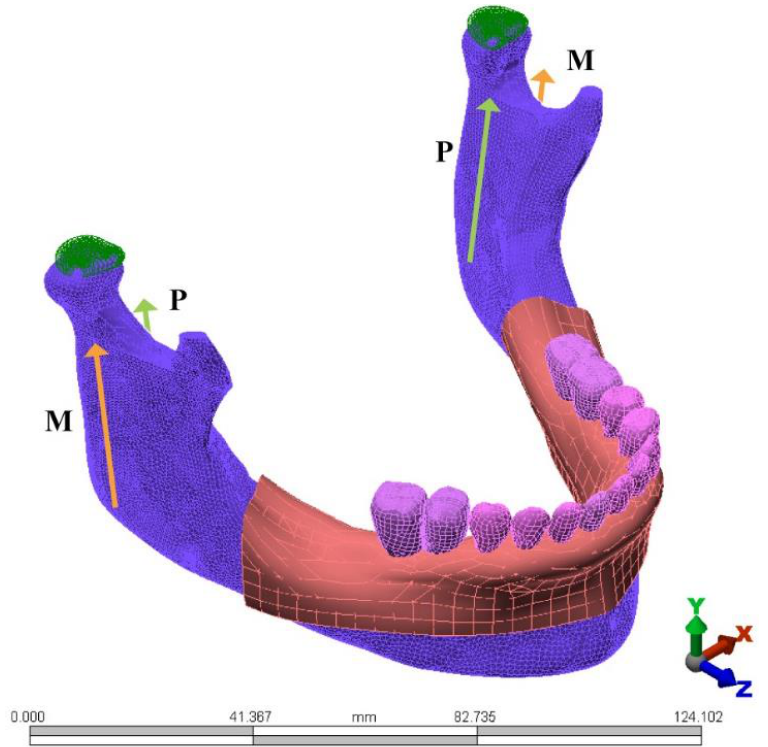
Figure 3. Complete mandible assembly in the simulation environment with applied forces corresponding to pterygoid muscles (P) and the masseter muscles (M) and restrictions at the temporomandibular joint surfaces.